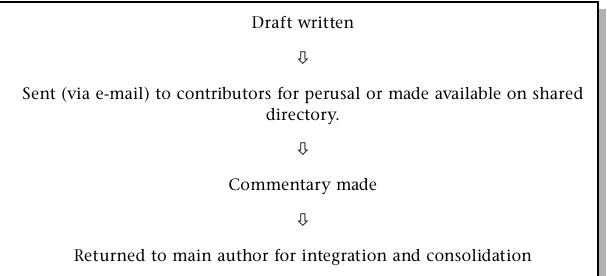
Figure 4: Illustration of the document collaboration process Due to the confidential nature of phase 3 it is regrettably not possible to publish the results, suffice to state that the client’s existing EDMS is the superior product. The saving and prior investment would not have warranted the loss of